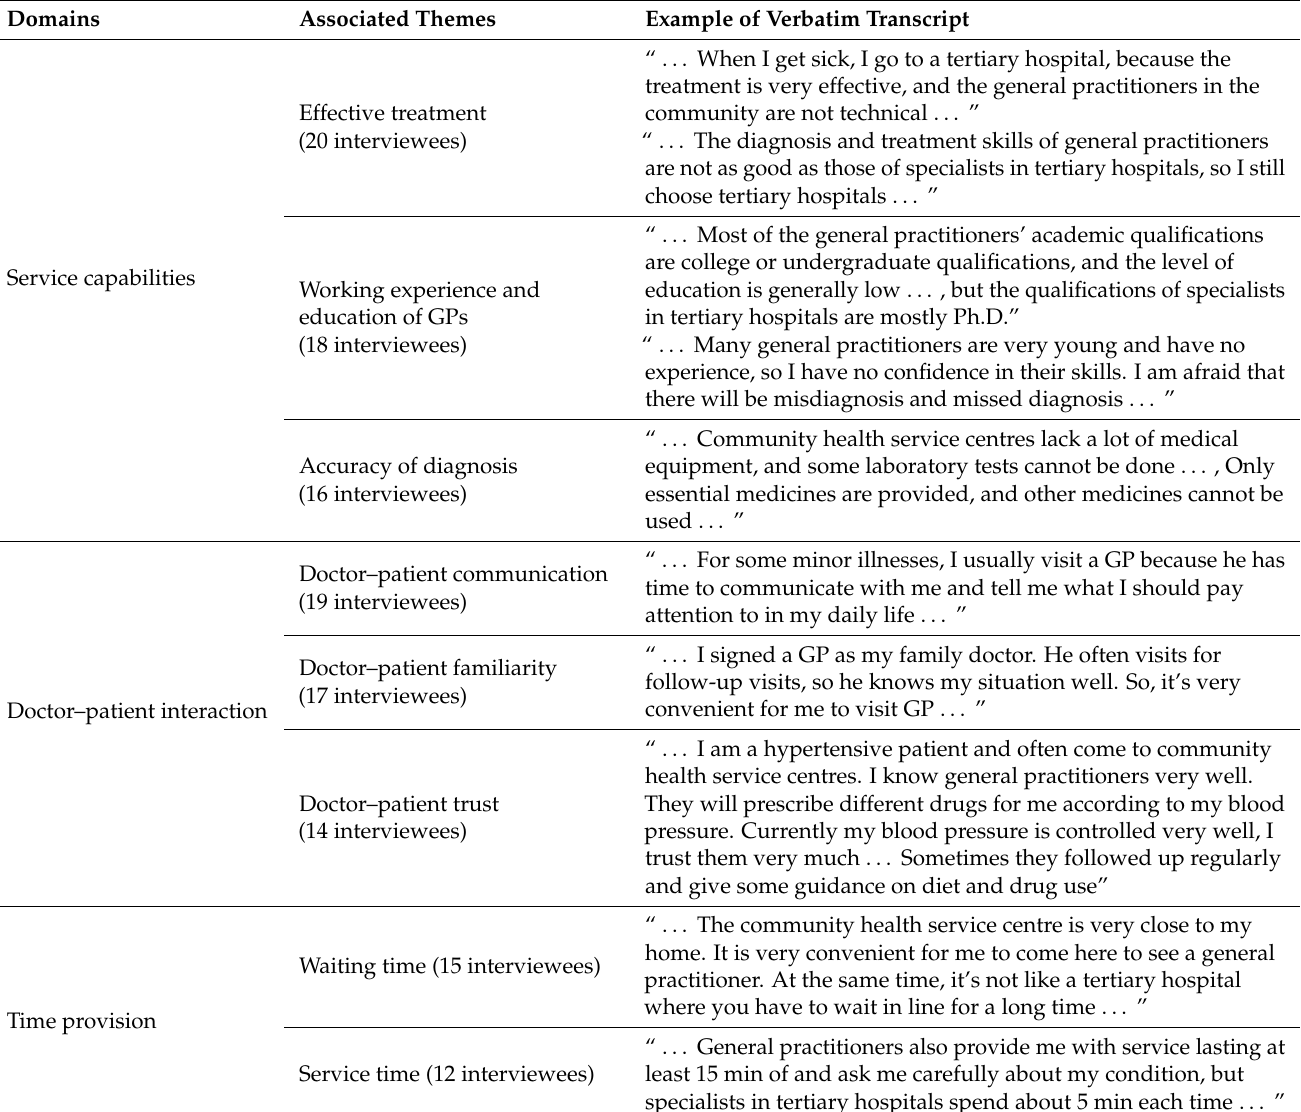
Table 5. Reasons for interviewees visiting/not visiting